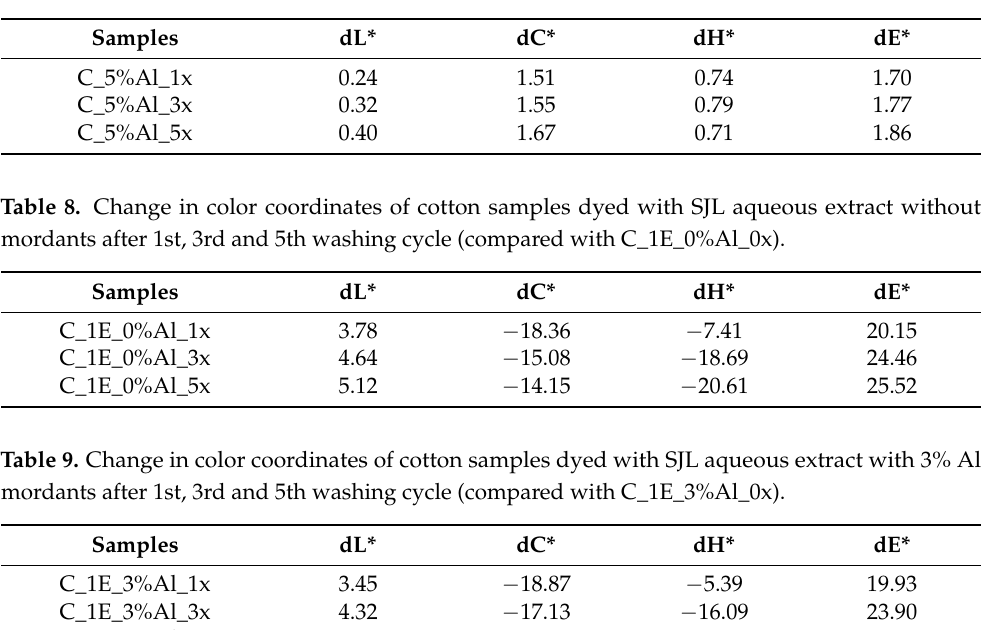
Table 7. Change in color coordinates of the cotton sample treated with 5% Al mordants after 1st, 3rd and 5th washing cycle (compared with C_5%Al_0x).